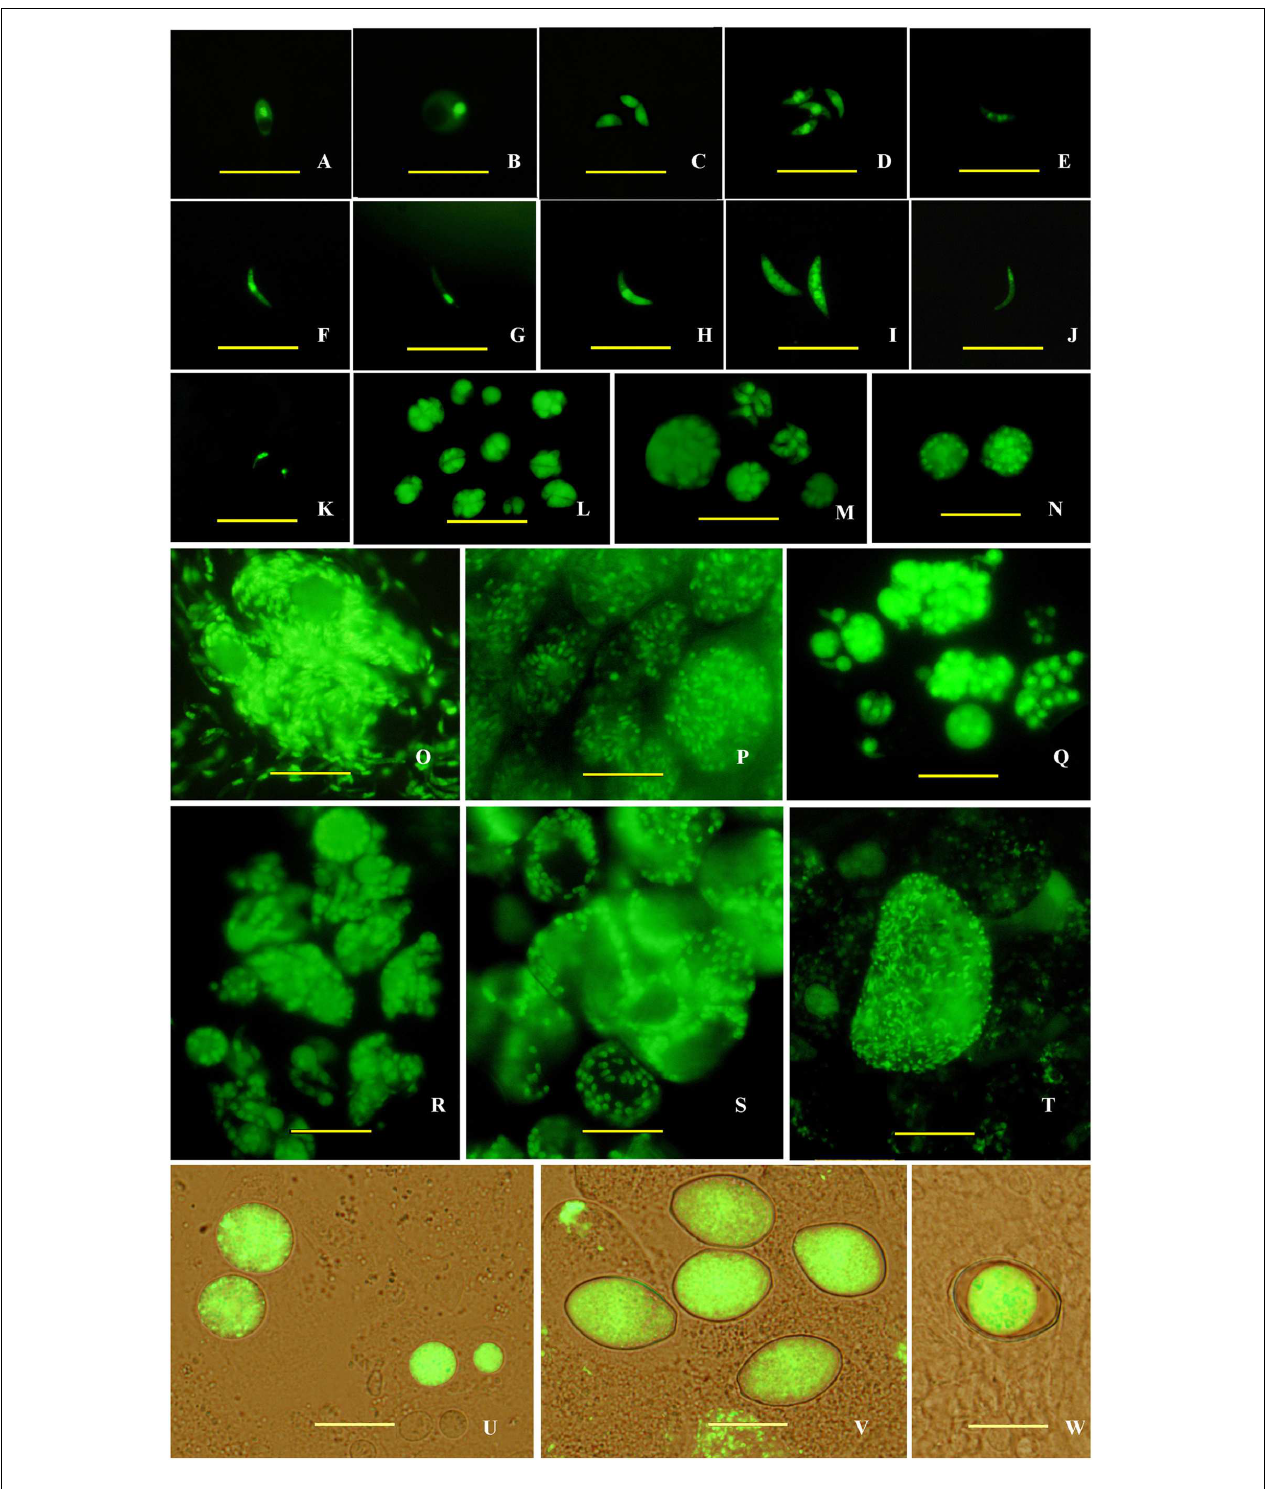
FIGURE 2 | Endogenous development of the transgenic E. intestinalis expressing YFP in rabbits. (A) A sporozoite at 4 h pi; (B) a trophozoite at 4 h pi; (C,D) first generation merozoites at 96 h pi; (E–G) second generation merozoites at 120 h pi; (H,I) third generation merozoites at 168 h pi; (J) a fourth generation merozoite at 216 h pi; (K) two microgametes at 216 h pi, (L,M) first generation schizonts at 96 h pi; (N–P) second generation schizonts at 120 h pi; (Q,R) third generation schizonts at 168 h pi; (S) fourth generation schizonts at 216 h pi; (T) a microgamont at 216 h pi; (U) macrogamonts at 216 h pi; (V) Zygotes at 216 h pi; (W) a mature oocyst at 216 h pi. Bar = 20 µ